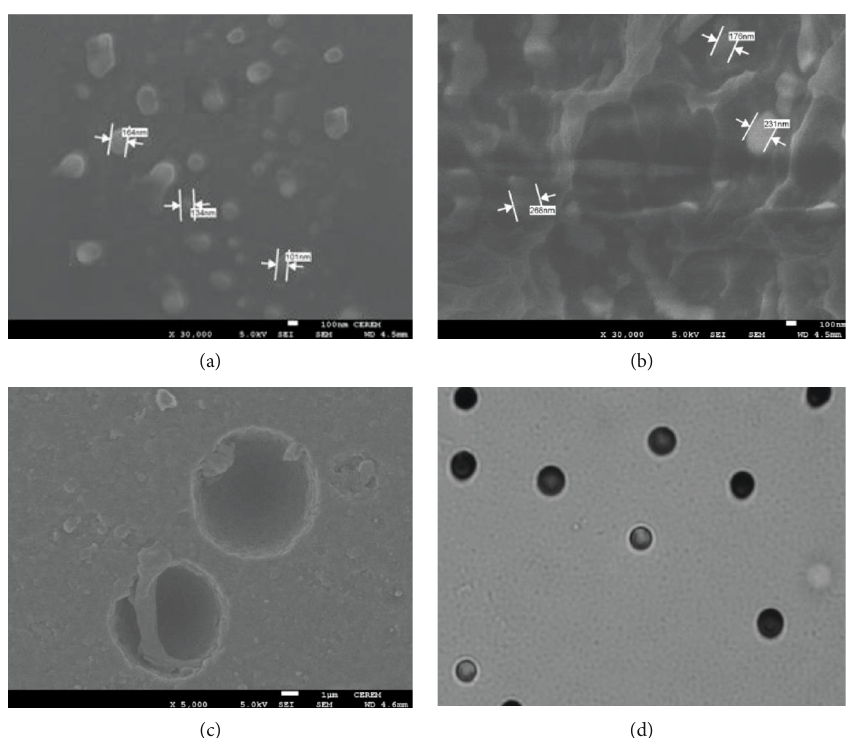
Figure 2: (a) SEM image of reference. (b) SEM image of only gamma-irradiated PM-355. (c) SEM image of gamma and alpha irradiated +chemically etched PM-355. (d) Microscopic image of alpha